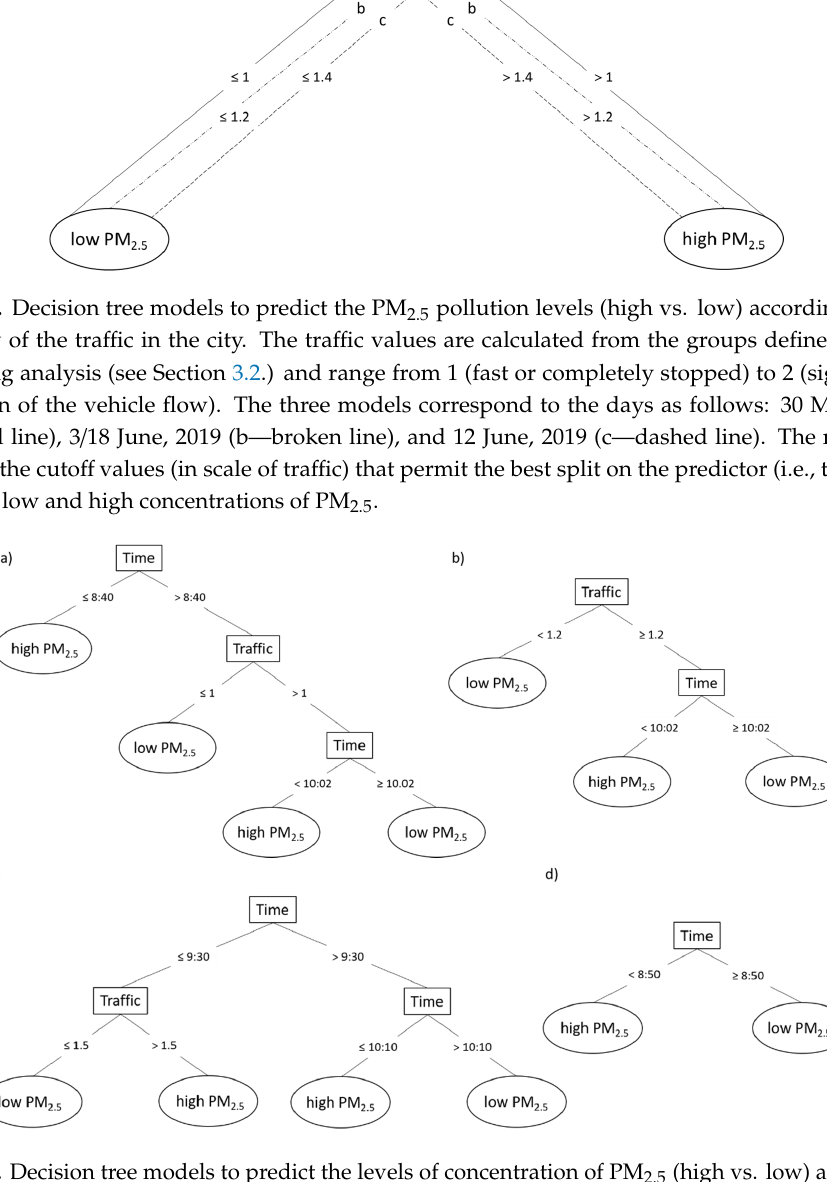
10 of 18 Figure 6. Decision tree models to predict the levels of contamination by PM 2.5 (high vs. low) according to an IDW interpolation of the concentrations measured at the four monitoring stations (Belisario, Centro, Cotocollao, and El Camal). The two models correspond to the days as follows: ( a ) 12 June, 2019 and ( b ) 3 June, 2019. The numbers indicate the cutoff values (in µg m − 3 ) that permit the best split on the predictor (i.e., IDW) to separate low and high concentrations of PM 2.5 . 3.3.2. PM 2.5 Prediction from Traffic Only Four models were built from the four different days of collected data. Figure 7 shows a good